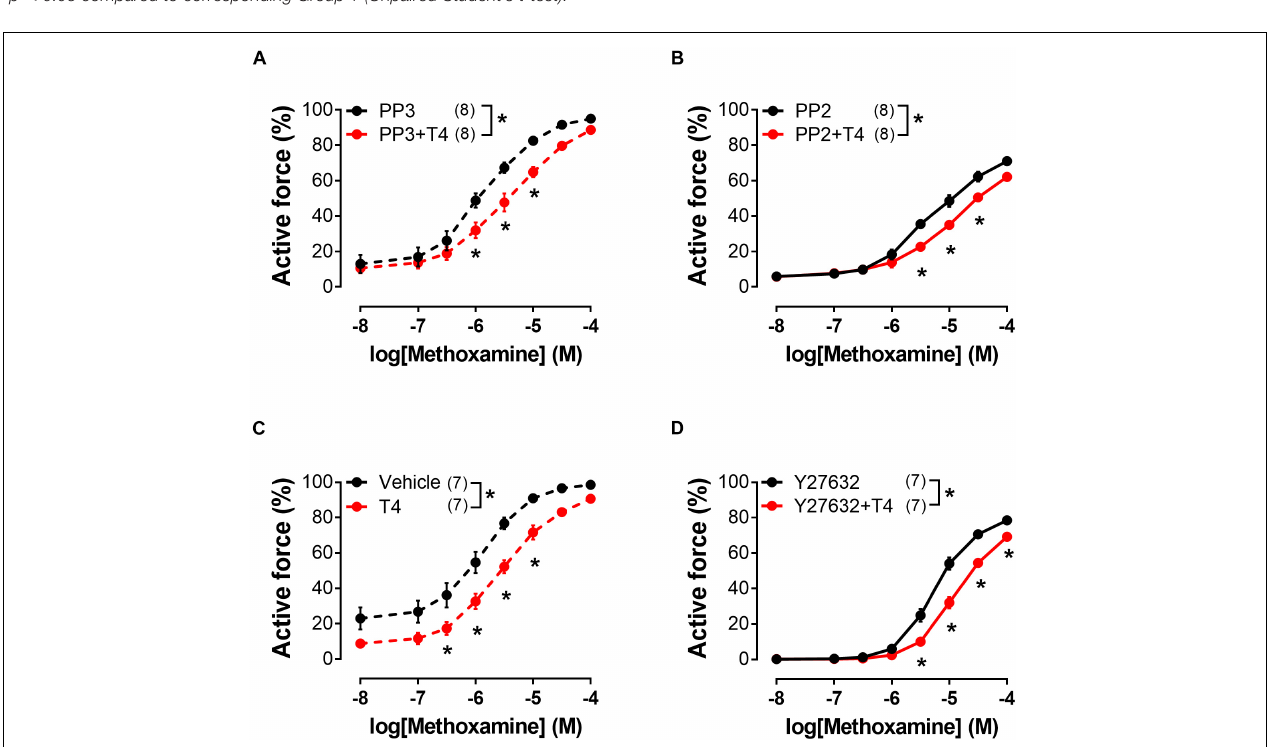
FIGURE 7 | T4-induced suppression of contractile responses of endothelium-denuded sural arteries to methoxamine persists in the presence of Src-kinase (PP2) and Rho-kinase (Y27632) inhibitors. Concentration-response relationships to methoxamine obtained after preincubation with T4 or vehicle in the presence of PP3 (A) (inactive analogue of PP2, 10 µ M), PP2 (B) (10 µ M), H 2 O (C) (vehicle for Y27632), and Y27632 (D) (3 µ M). Number in parentheses represents the number of animals. * p < 0.05 compared to respective control group (Repeated Measures ANOVA with Tukey’s post hoc